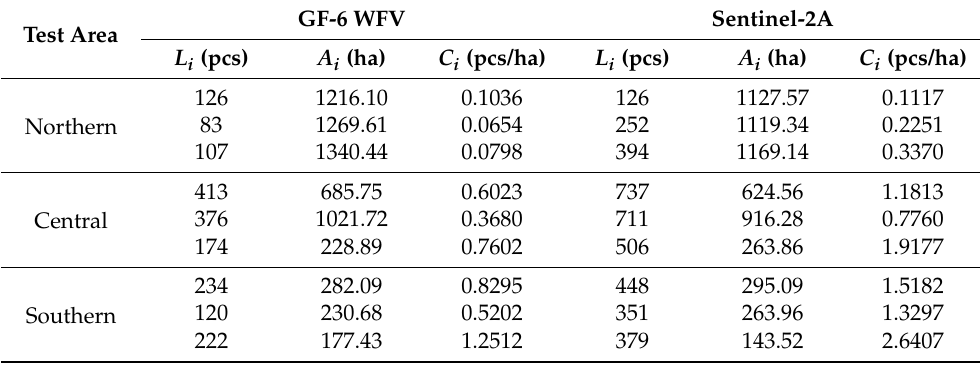
Table 17. Landscape fragmentation